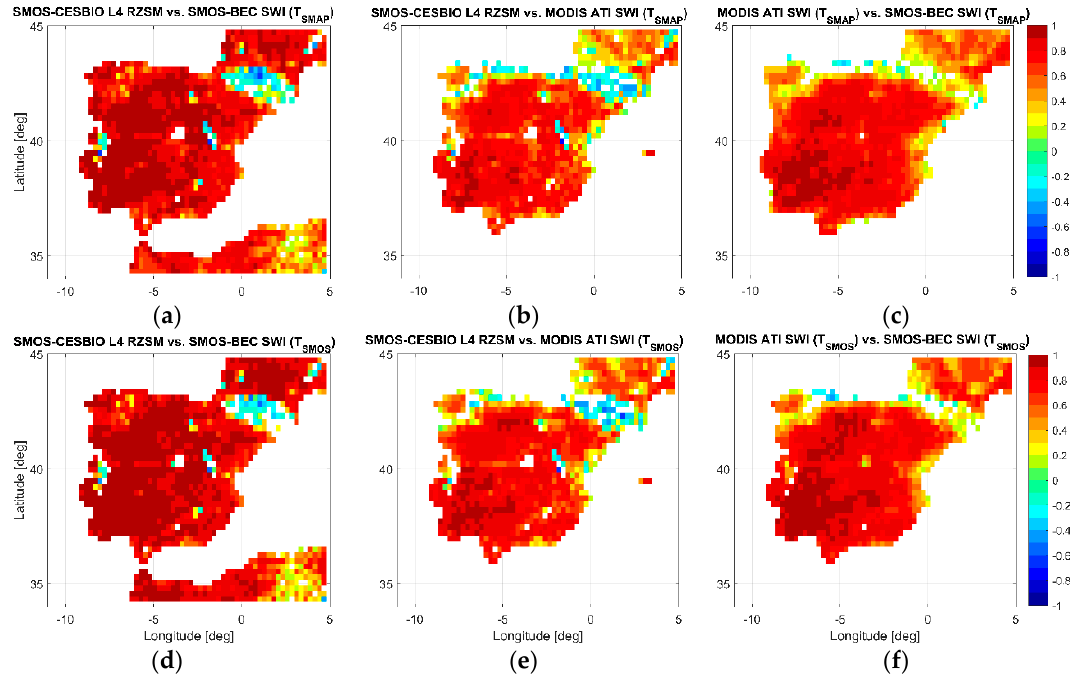
Figure 7. Temporal correlation maps at 25 km between: ( a ) SMOS-CESBIO L4 RZSM and SMOS-BEC SWI (T SMAP ); ( b ) SMOS-CESBIO L4 RZSM and MODIS ATI SWI (T SMAP ); ( c ) MODIS ATI SWI (T SMAP ) and SMOS-BEC (T SMAP ); ( d ) SMOS-CESBIO L4 RZSM and SMOS-BEC SWI (T SMOS ); ( e ) SMOS-CESBIO L4 RZSM and MODIS ATI SWI (T SMOS ); and ( f ) MODIS ATI SWI (T SMOS ) and SMOS-BEC (T SMOS ).